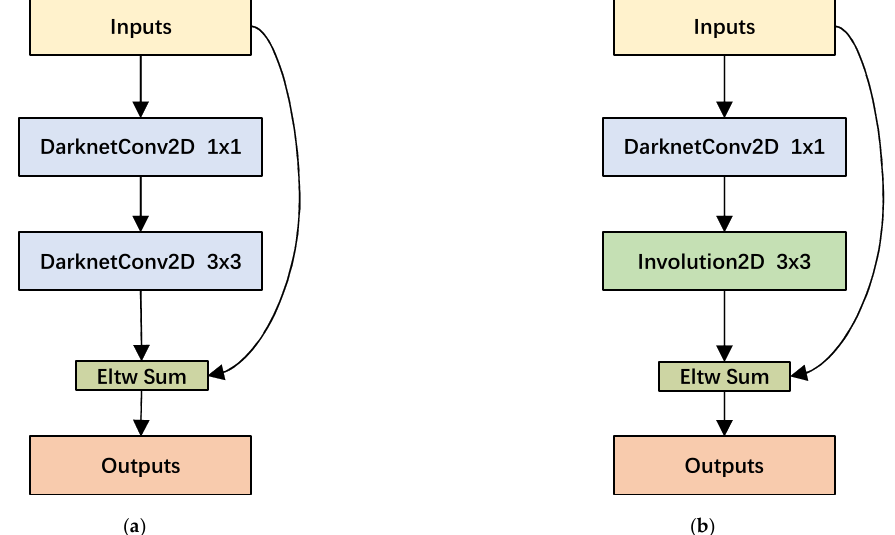
Figure 5. Sub-residual block structure diagram. ( a ) original bottleneck. ( b ) improved bottleneck.